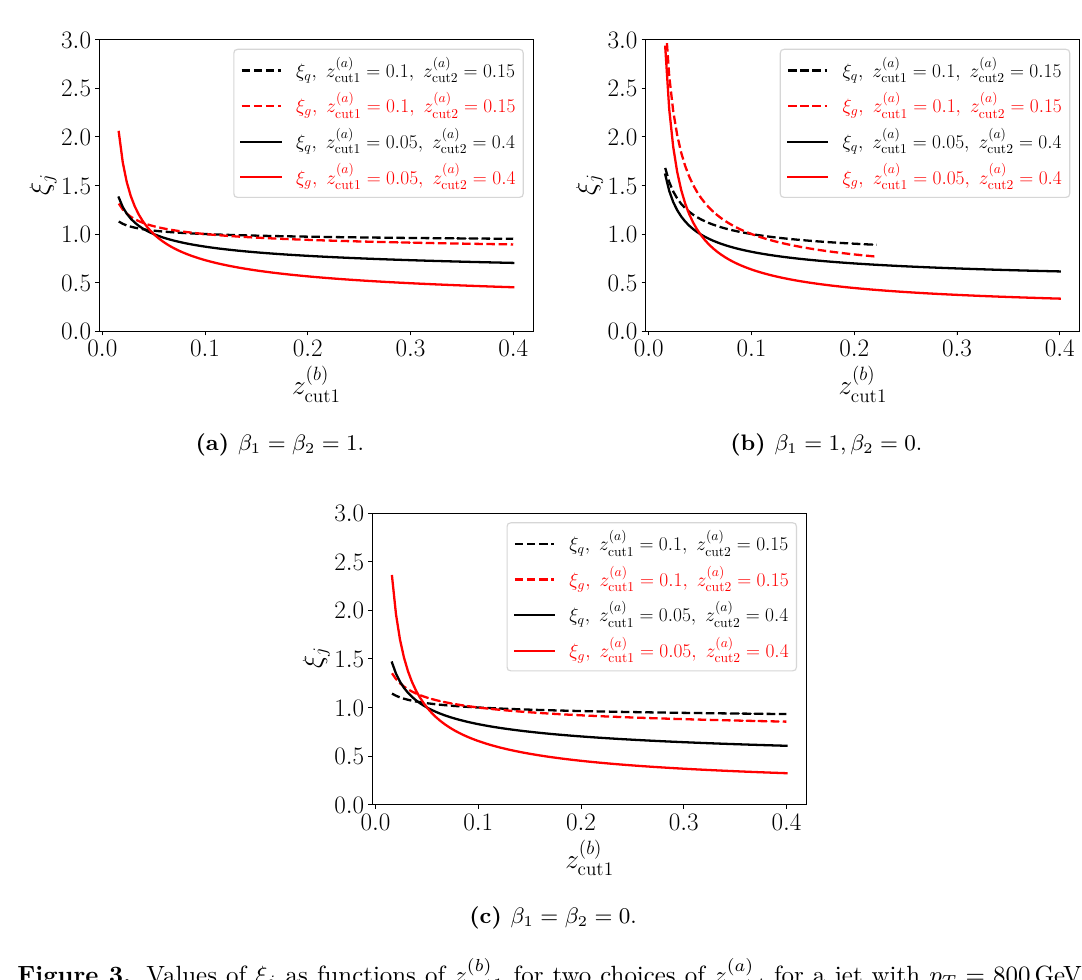
for two choices of z ( a ) for a jet with p T = 800 GeV, cut1 cut i